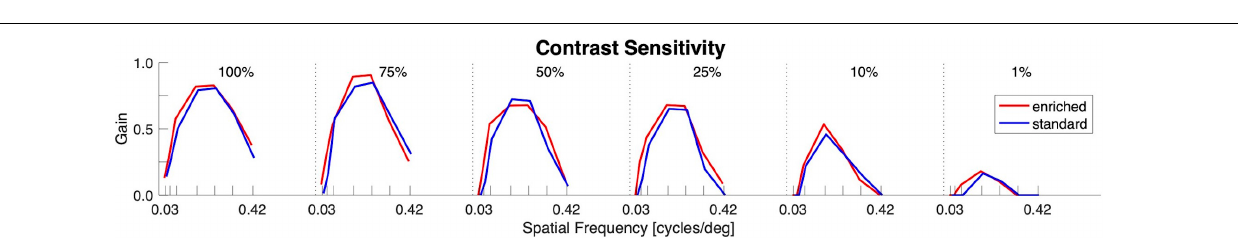
Frontiers in Behavioral Neuroscience |